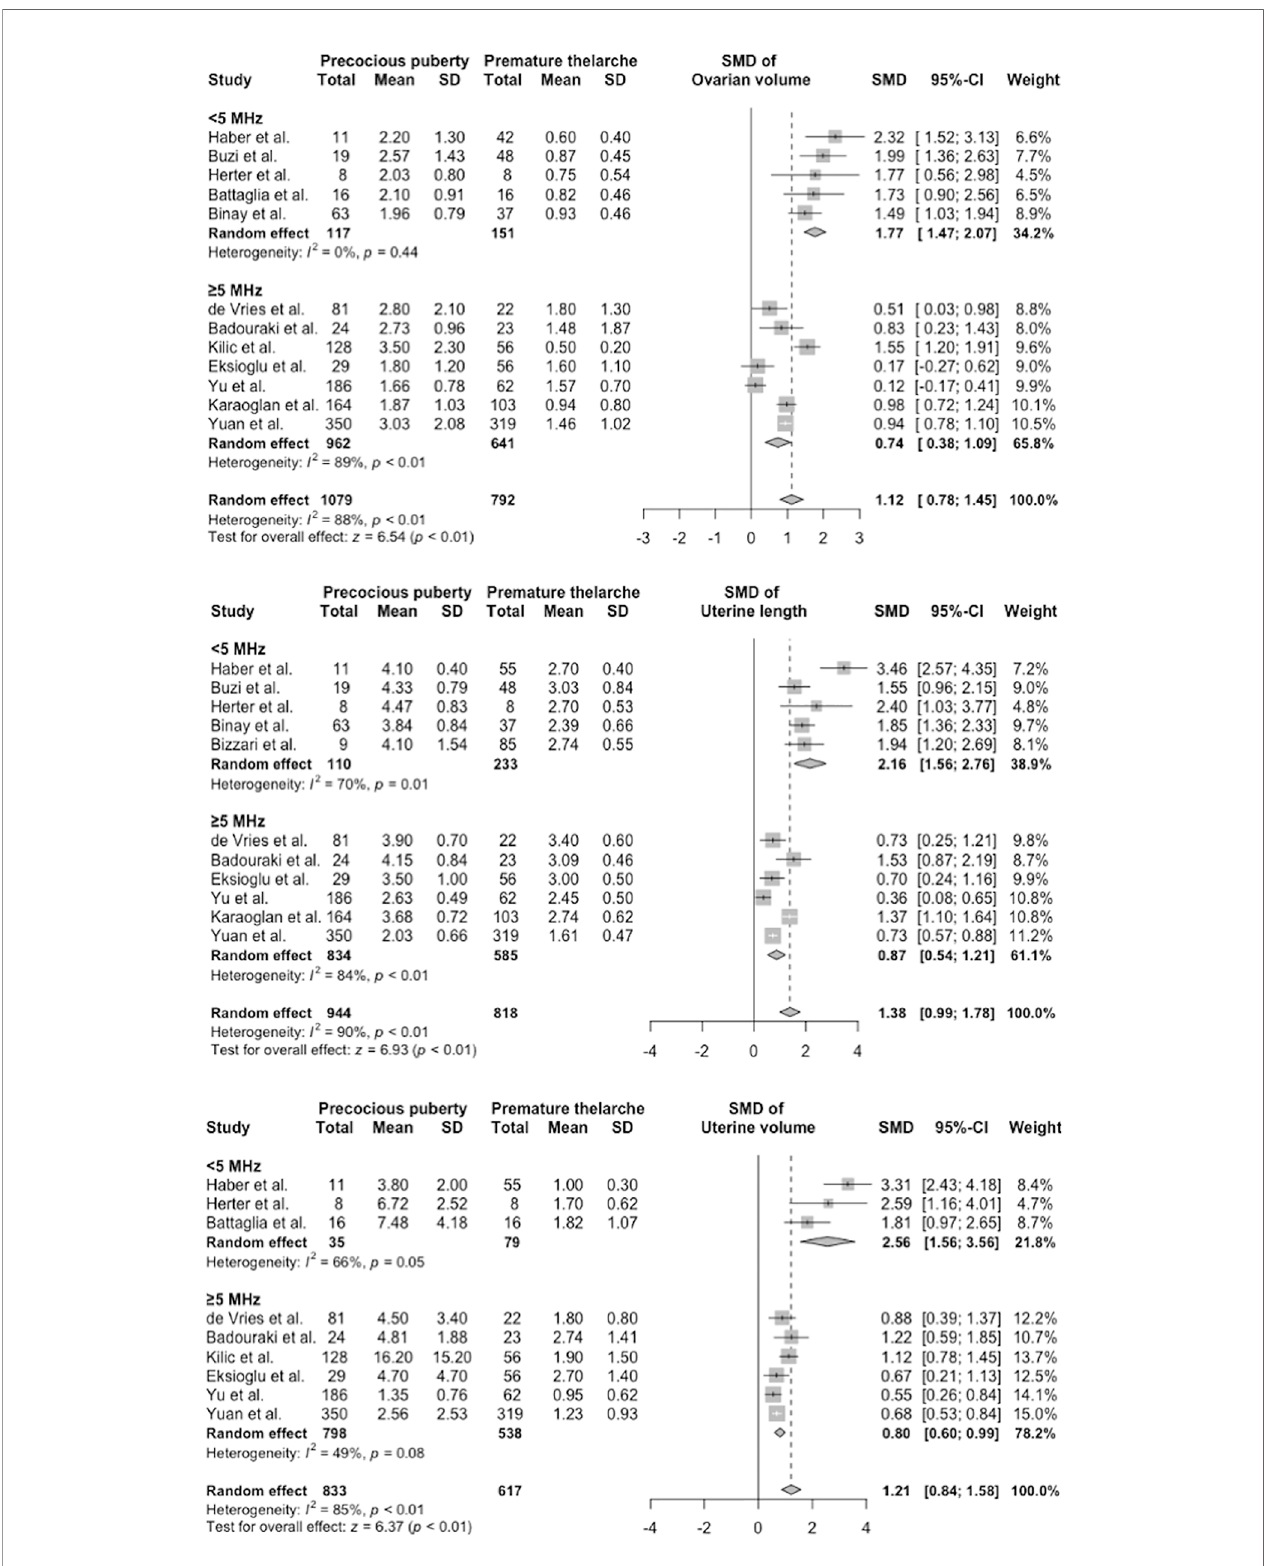
FIGURE 3 | Subgroup analysis of ovarian volume, uterine length, and uterine volume. CI, con fi dence interval; SD, standard deviation; SMD, standardized mean